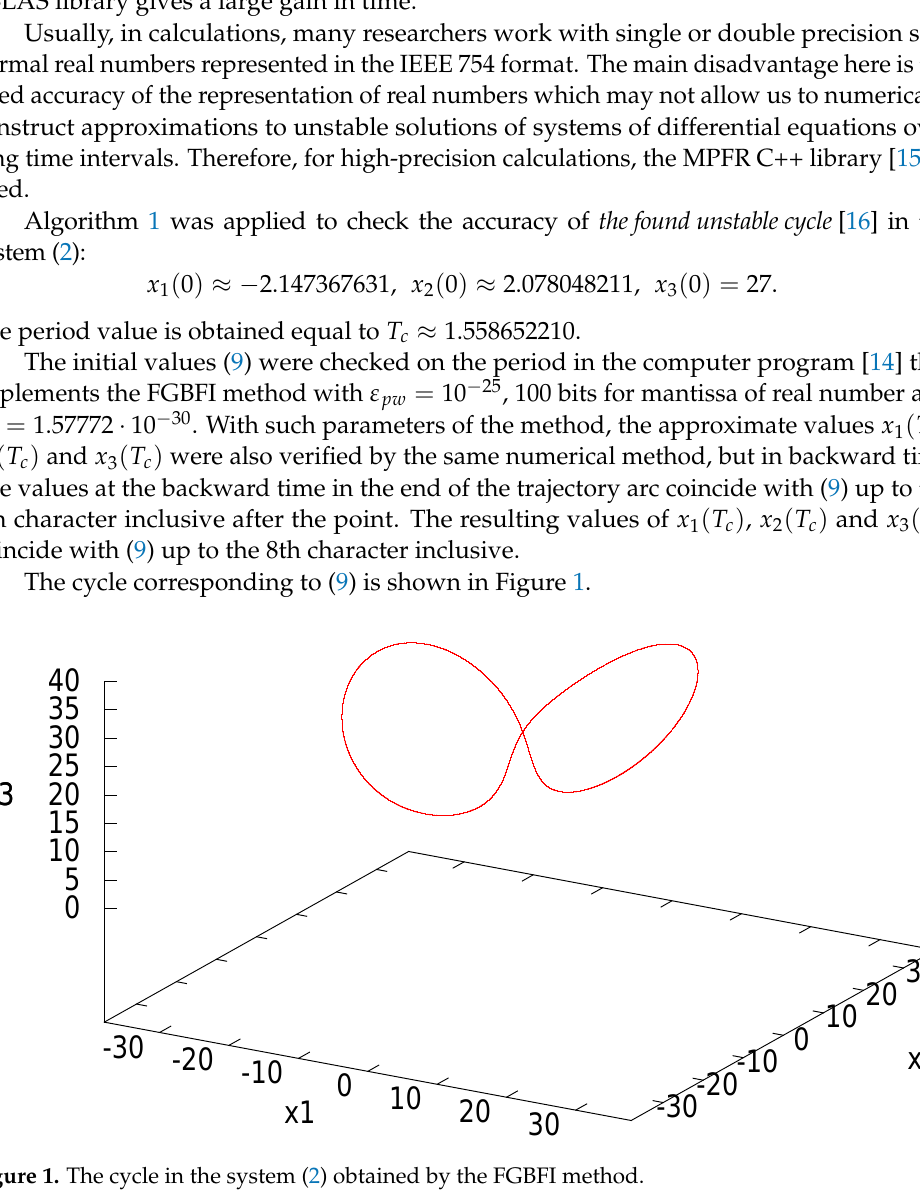
Figure 1. The cycle in the system (2) obtained by the FGBFI method.